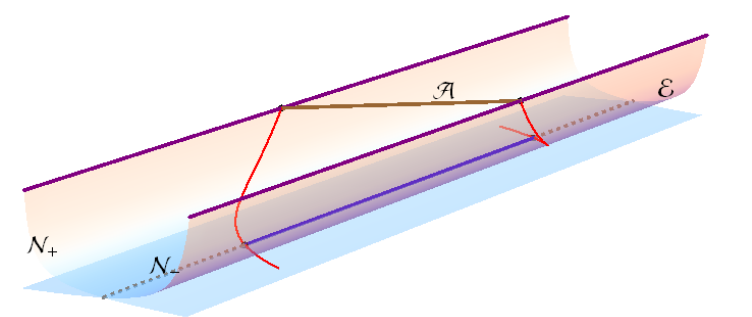
Figure 10 . We assume E ( v (cid:0) ), with v (cid:0) = (cid:0)1 , is the point that connected to @ (cid:0) A on the real 0 0 boundary through the null geodesics (cid:13) (cid:0) . When we push @ (cid:0) A to the cuto(cid:11) boundary along N (cid:0) , the null geodesic (cid:13) (cid:0) that goes through it will change accordingly as well as the intersection point with E . In such a way the curve E is regulated through the null geodesics.